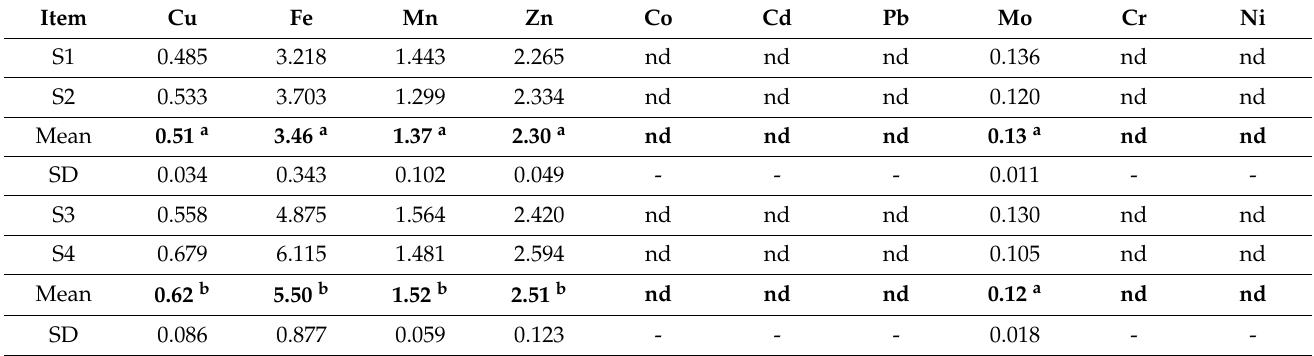
Table 5. Trace elements (mg/100 g DM) content of extruded (S1, S2) and baked (S3, S4) dog